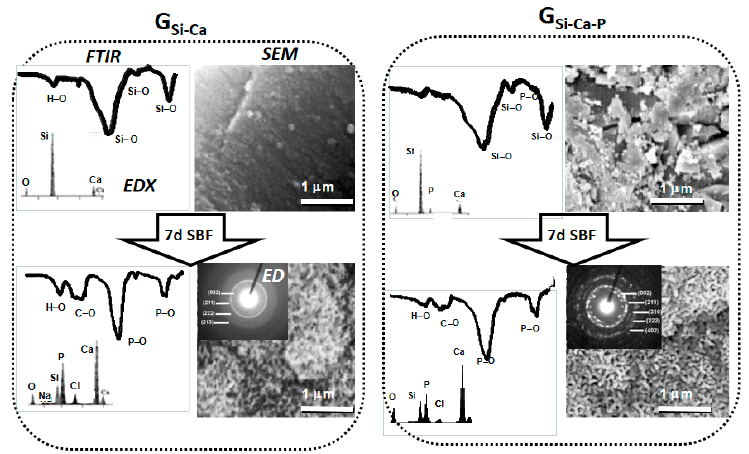
Figure 2. FTIR and EDX spectra, SEM images, and ED patterns of two bioactive glasses before and after being soaked for 7 days in SBF. Left : a P ‐ free glass, G Si–Ca . Right : a glass with analogous composition but including 3 mol ‐ % of P 2 O 5 , G Si–Ca–P .